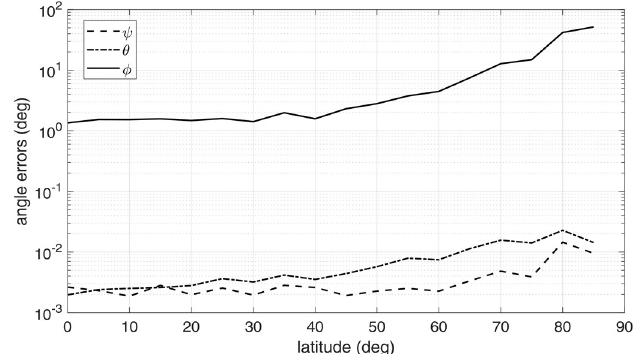
Figure 7. Attitude errors as a function of latitude for an Earth-like spheroid with atmosphere, h / R E = 0.2 [9].